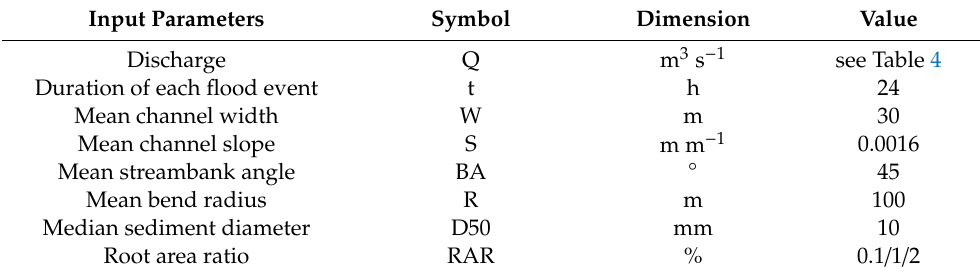
Table 3. Input parameters for the cross section at the Thur River catchment in Canton of Thurgau, Switzerland. Discharge (Q) for the 12 scenarios (events) are presented in Table 4.